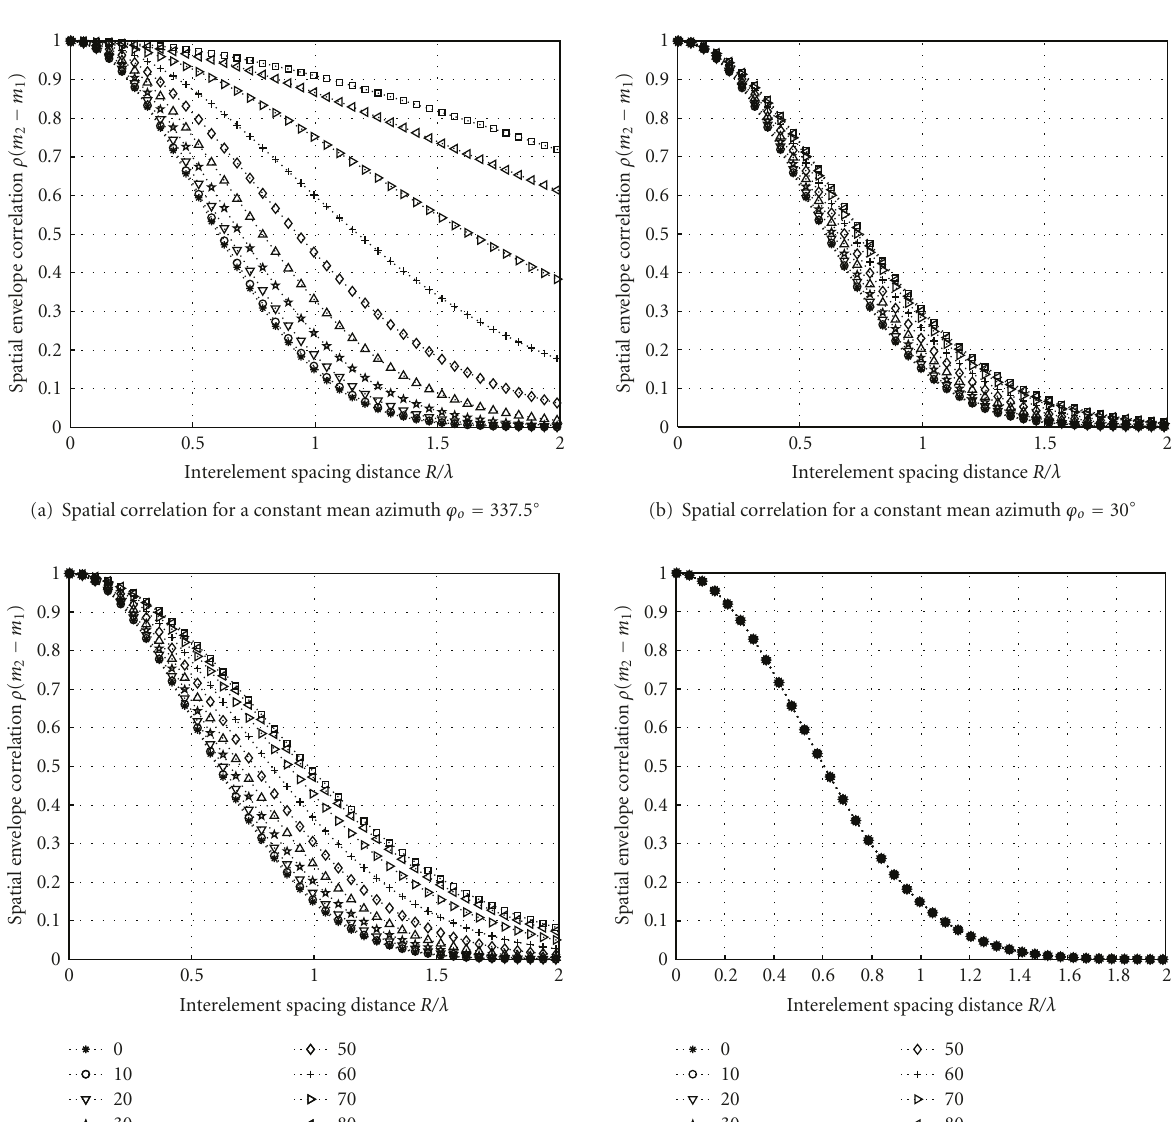
(d) Spatial correlation for a constant mean azimuth ϕ o = 67 . 5 ◦